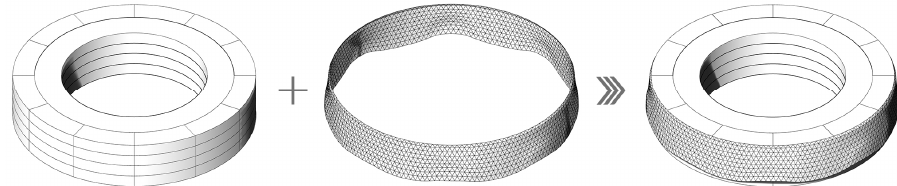
Figure 5. Parametric skin creation process (self-developed).